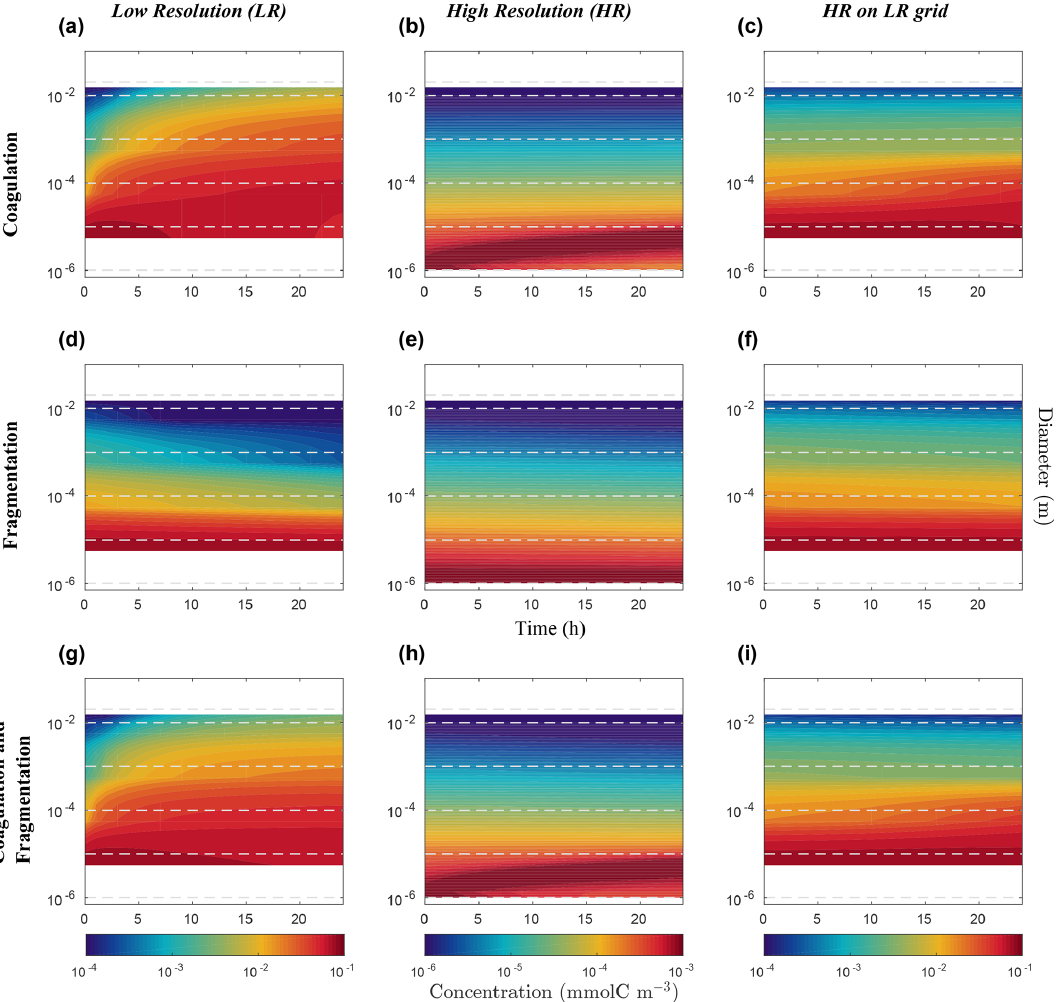
Figure 7. Hovmöller plots of carbon concentration as a function of particle diameter over a 24h period for the nonlinearly discretized configuration (E2). Simulations for coagulation and fragmentation considered separately (on top and middle lines, respectively) and combined (on bottom line), and for LR (left column) and HR (middle column), are shown. The right column shows the HR when mapped to the LR grid. Note the logarithmic scale for the vertical axis representing particle diameter (m) and for the colour scale representing carbon concentrations (mmolCm − 3 ). Concentration value scales are different between our resolutions and are set to allow an easy comparison. Dashed lines represent the bounds of each LR size bin. Dealing with size spectrum logarithmic scale, middle size bin concentration value will induce no concentration data in the lower bound of the first size bin in the LR ( a , d , g ) and for the HR mapped to the LR grid ( c , f , i